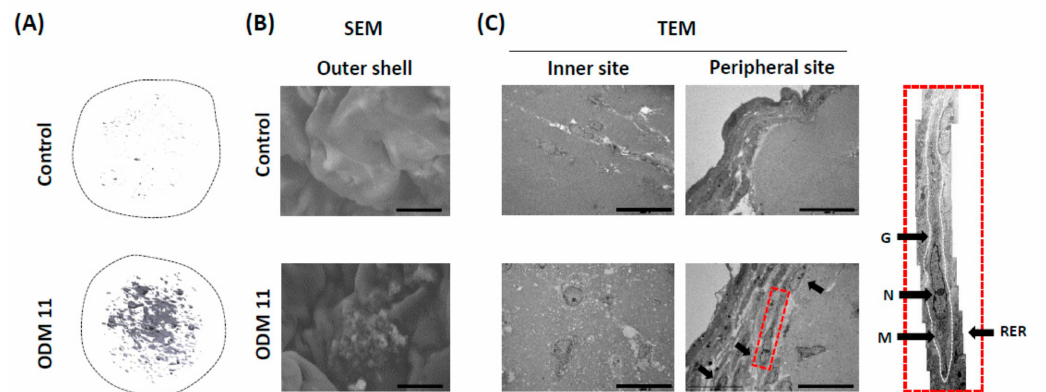
Figure 3. Imaging evaluation using micro-CT and EM demonstrates mineralization and odontoblastic di ff erentiation in ODM 11. ( A ) Representative images of Micro-CT revealing marked mineralization in ODM 11. However, only a scanty amount of mineralization was shown in the control. ( B ) SEM images revealed the calcified matrix on the surface of organoids with tubule. ( C ) TEM image showed odontoblast-like cells with an elongated shape. These cells were located mostly in the peripheral area. In the peripheral area, odontoblast-like cells had proper cellular structures. Scale bar = 10 µ m for SEM and 20 µ m for TEM. Micro-CT: Micro-compute tomography; EM: Electron microscope; SEM: